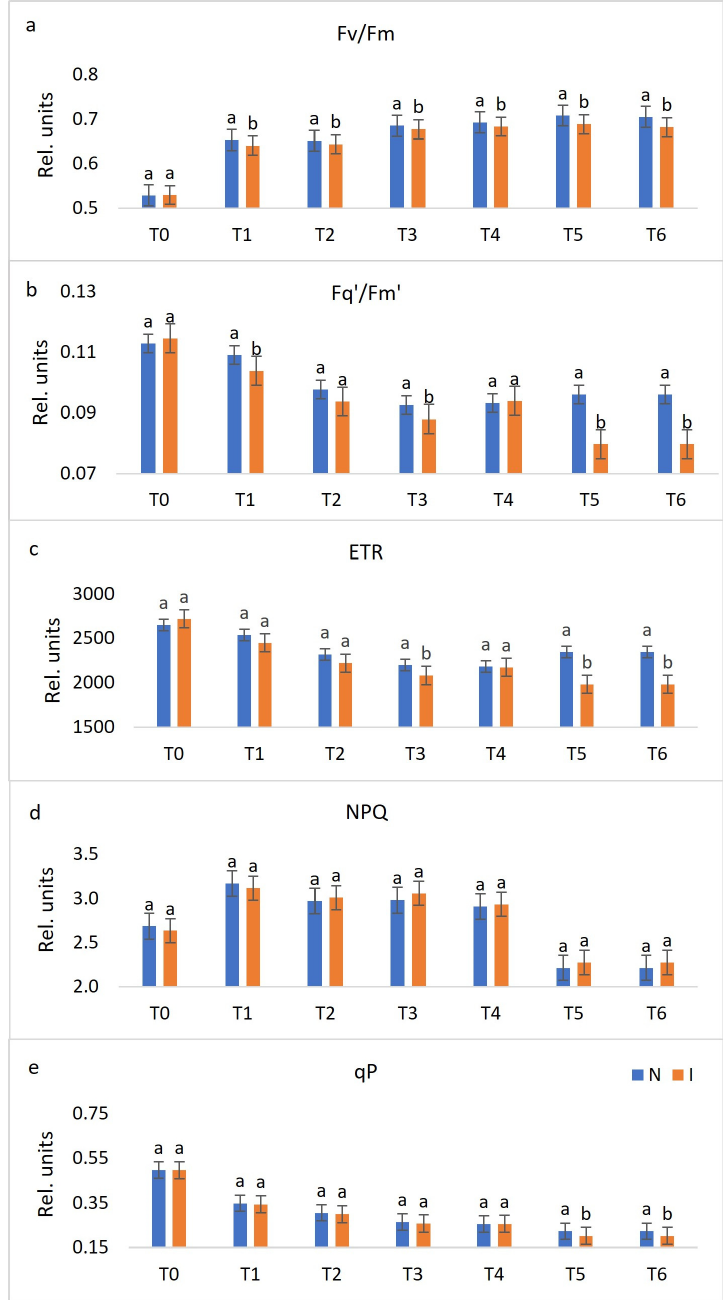
Figure 1. Changes between non-infected (N) and infected (I) leaf discs throughout seven terms (before treatment (T 0 ), one day post-inoculation (dpi) (T 1 ), two dpi (T 2 ), three dpi (T 3 ), four dpi (T 4 ), six dpi (T 5 ) and eight dpi (T 6 )) in chlorophyll fluorescence parameters (the average of 30 genotypes). Differences between the means were evaluated by Duncan’s multiple range test at a confidence level of 95% ( p < 0.05). Means with the same letter are not significantly different. Sub-figures depict parameters as follows: ( a ) Fv/Fm, ( b ) Fq’/Fm’, ( c ) ETR, ( d ) NPQ, and ( e ) qP. Multispectral imaging parameters Hue (Figure 2a) and FarRed (Figure 2b) were not significantly different during the final two measurements between non-infected and in- fected leaf discs, meaning that by these two parameters, it is not possible to distinguish between non-infected and infected leaf discs from the occurrence of visible symptoms.